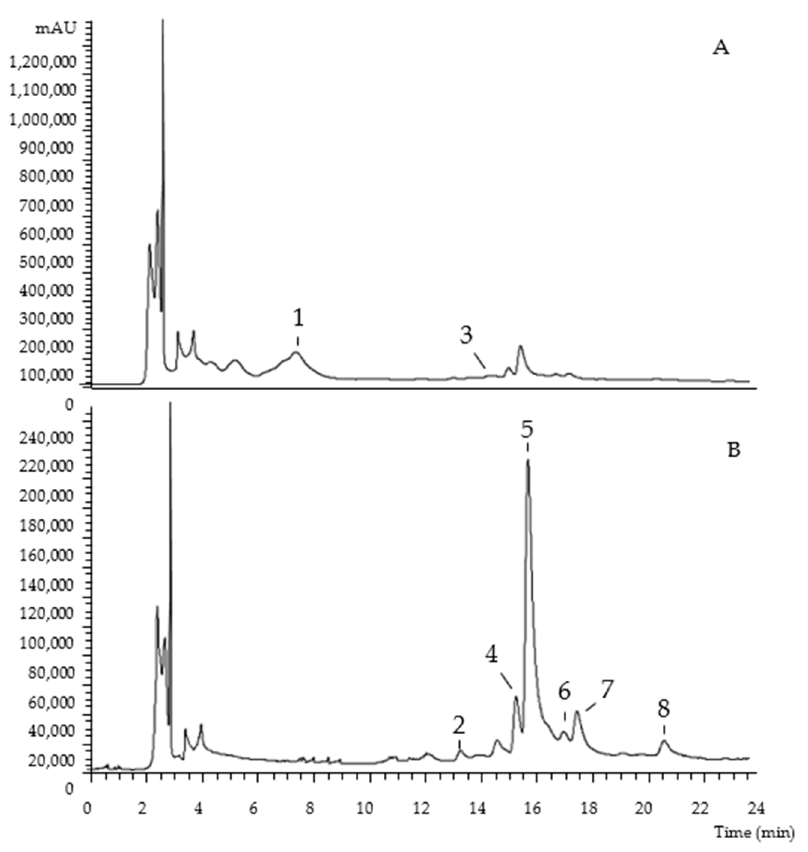
Figure 1. Portuguese ‘Common Pumpkin’ seeds chromatogram, recorded at 280 nm ( A ) and 370 nm ( B ). The family of flavonoids was the most abundant in terms of the number of compounds detected, mainly O -glycosylated derivatives of quercetin, kaempferol, and isorhamnetin, as previously described by Iswaldi et al. [22] in Cucurbita pepo L. The detected compounds could be divided in two groups, the first one presented two sugar moieties linked to the flavonoid aglycone (peaks 6, 7, and 8), and the second one presented three sugar moieties (peaks 2, 4, and 5). Peaks 6 ([M-H] − at m/z 593) and 7/8 ([M-H] − at m/z 623)